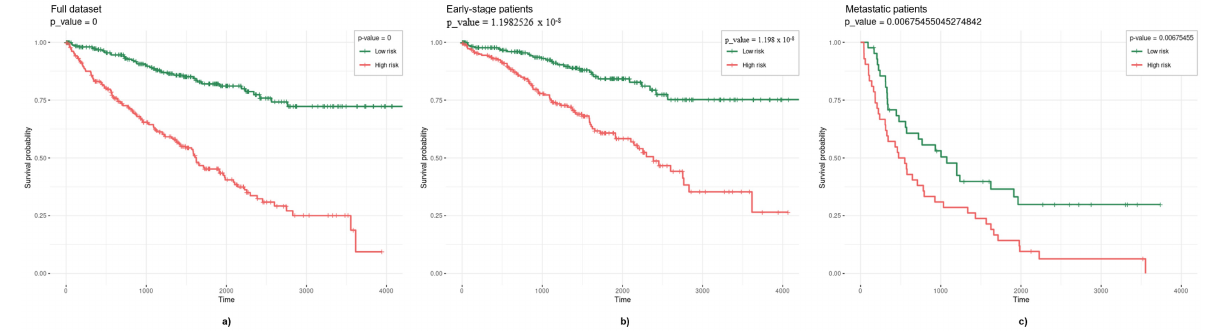
Figure 13. Kaplan–Meier curves obtained when applying a multivariate Cox model to a gene set comprising genes correlated with survival outcome in ccRCC and genes with some enriched ontology associated ( p = 24). ( a ) Full dataset ( n = 527); ( b ) early stage patients ( n = 441); ( c ) metastatic patients ( n = 84). Table 8. List of genes and corresponding β coefficients obtained in a multivariate Cox survival model using ridge regression. HR (hazard ratio) gives the effect size of covariates and it is calculated by exp ( β ) . HR = 1, no effect; HR < 1, reduction in the hazard; HR > 1, increase in the hazard.